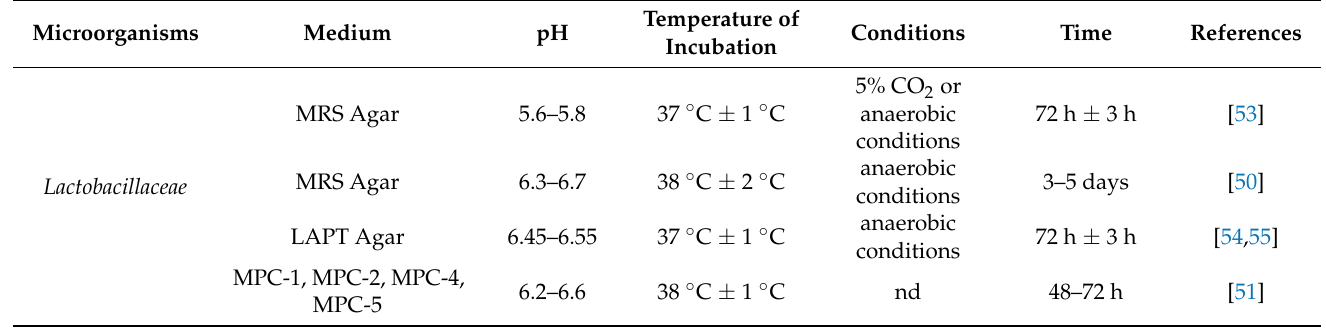
Table 2. Media and incubation conditions for individual types of probiotic